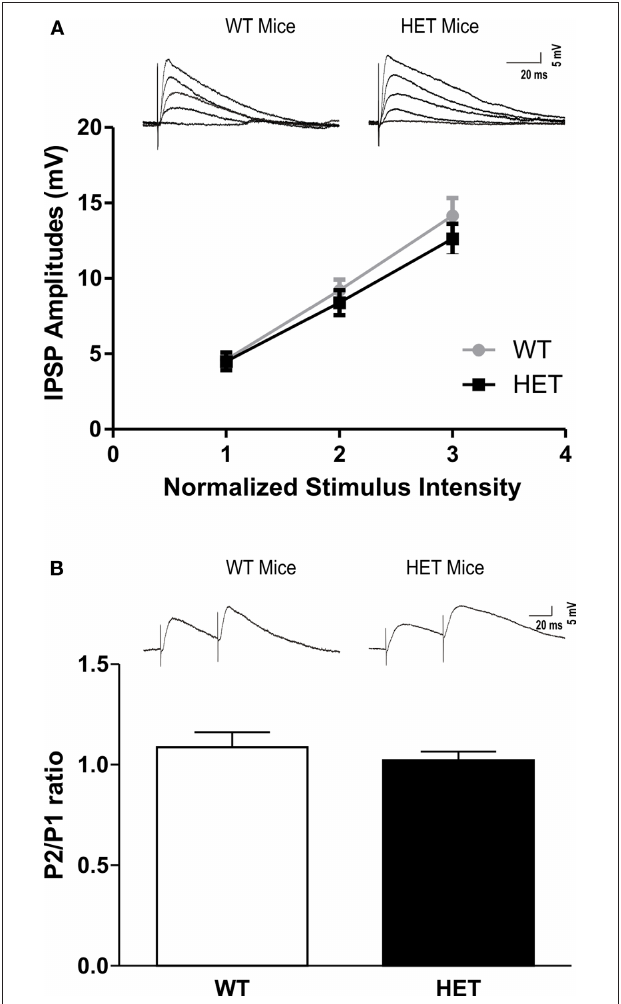
FIguRe 1 | There is no significant difference in basal gABAergic transmission in the CeA between WT and HeT mice. (A) Basal input/output curves of mean GABAA-IPSP amplitudes in the CeA were not altered in HET compared to WT mice (WT: n = 21 and HET: n = 22). (B) Paired-pulse facilitation protocol showed no differences in P2/P1 ratio between WT and HET mice (WT: n = 18 and HET: n = 22). The top panels in (A) and (B) show representative recordings from individual CeA neurons. The values are presented as mean IPSP amplitudes ± SEM. Significance was calculated by Student’s t -test and set at * P <